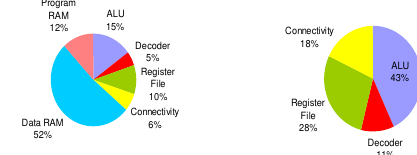
Figure 11. Percentage of total processor power consumed per module with (a) program and data RAMs and (b) standalone